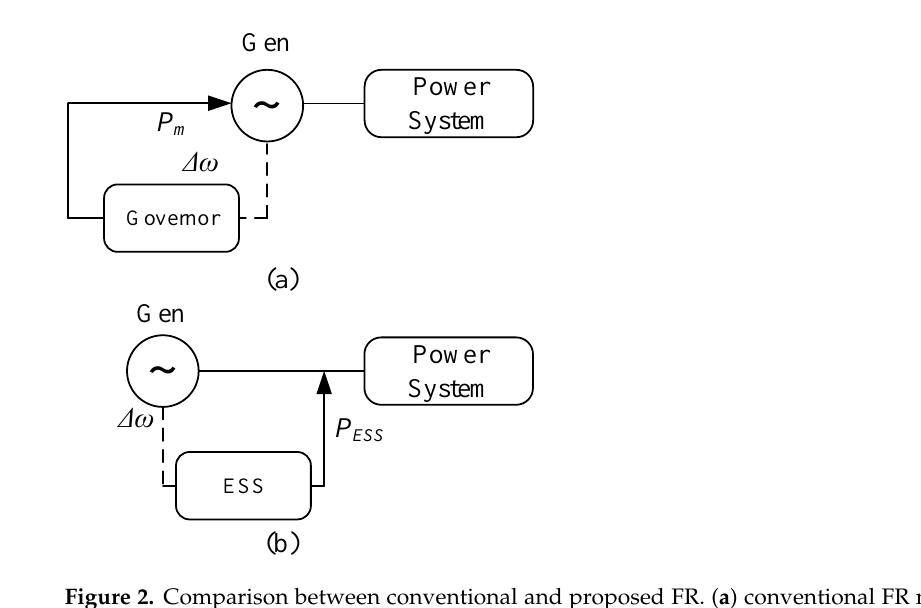
Figure 2. Comparison between conventional and proposed FR. ( a ) conventional FR method with governor; ( b ) proposed method of FR ESS instead of